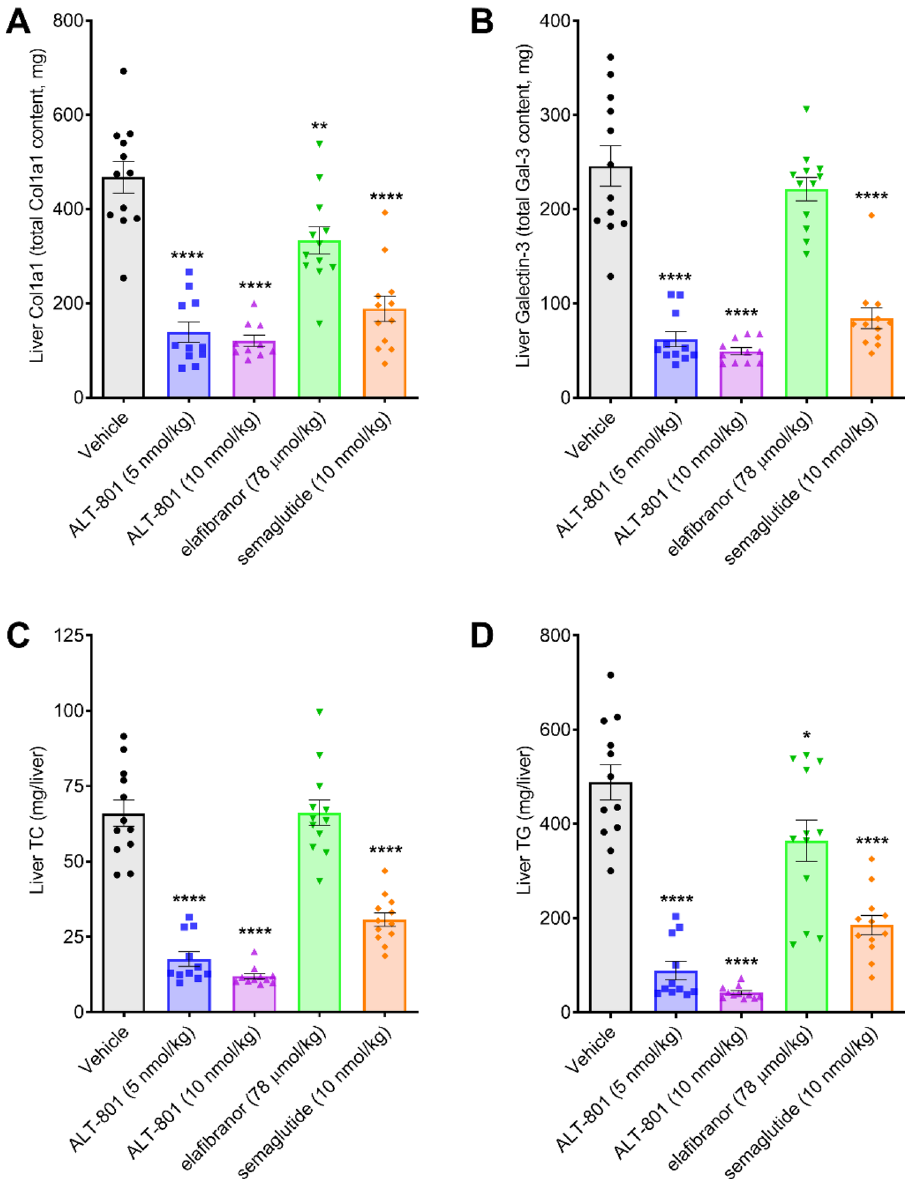
liver Col1A1. ( B ) Change in terminal liver Gal-3. Quantification of Col1A1 and Gal-3 was determined by histomorphometry. ( C ) Total liver cholesterol (TC) content. ( D ) Total liver triglycerides (TG). Data are expressed as mean ± SEM (n = 11–12). * p < 0.05, ** p < 0.01, **** p < 0.0001 vs. vehicle